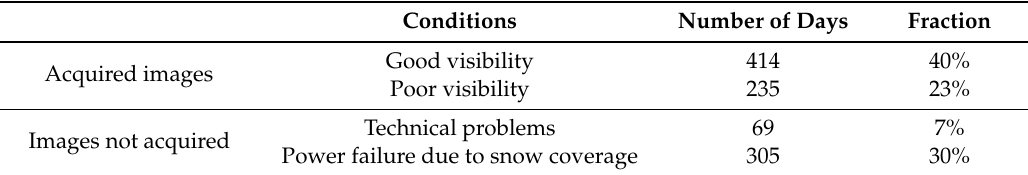
Table 2. Summary of the acquisitions during different visibility conditions. During winter, the system is frequently subjected to power failures and/or extreme weather conditions, during which data acquisition is impossible. In summer, the system runs almost continuously.